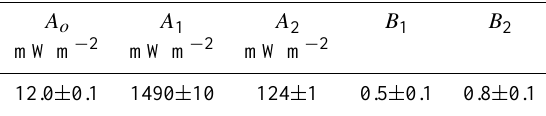
Table 2. Fitting values for coefficients in Eq. (2).